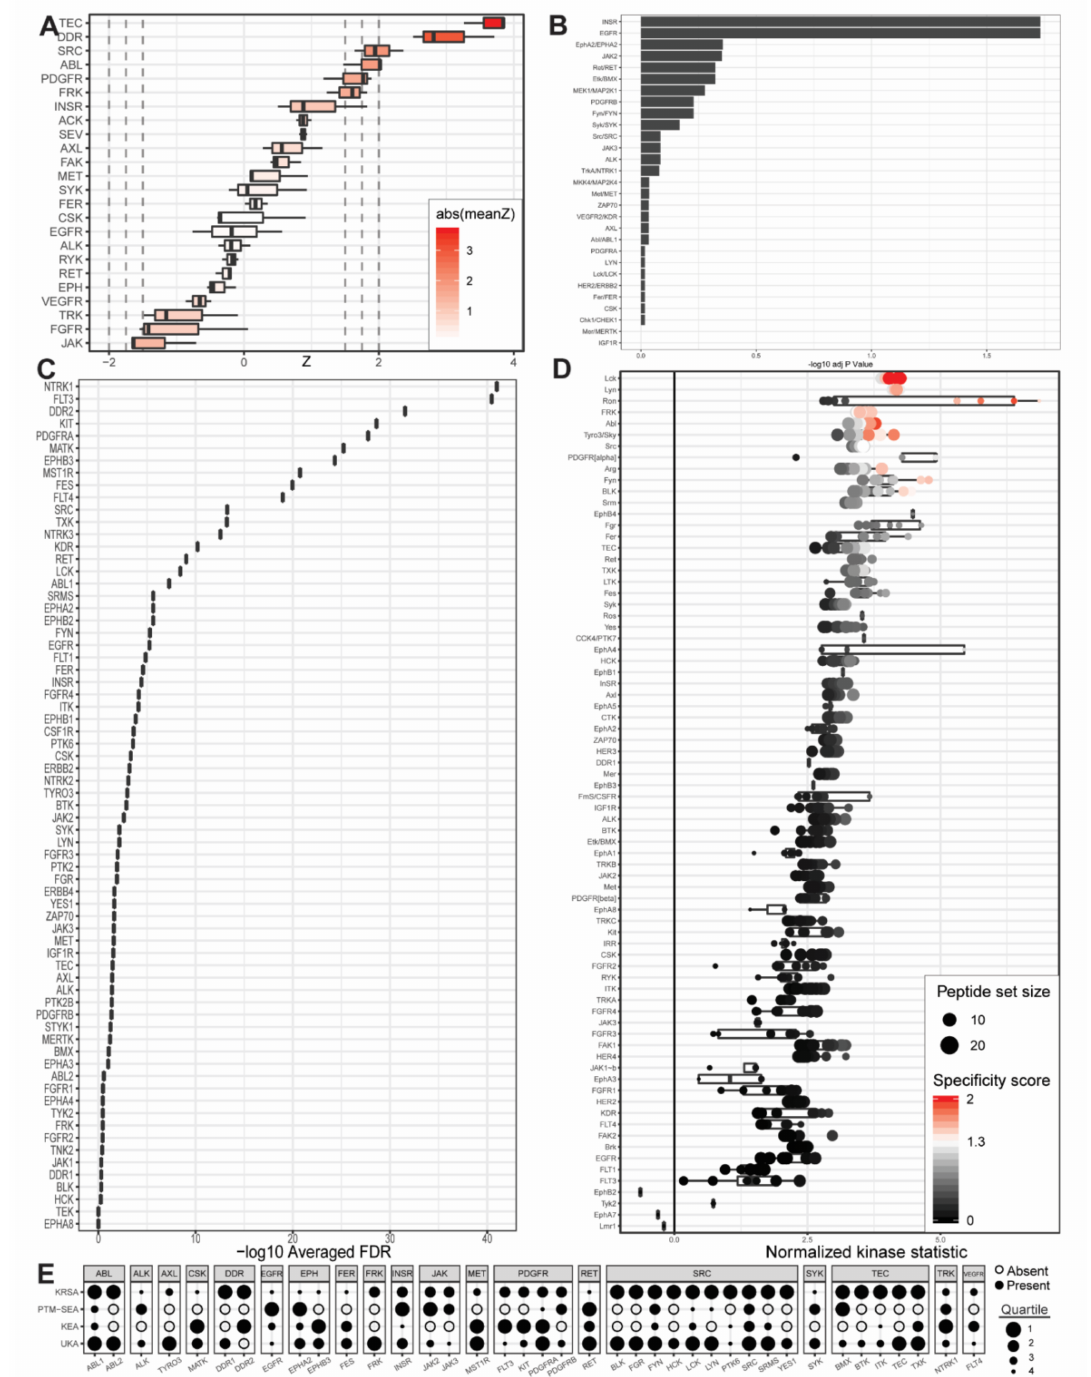
Figure 2. Outputs from upstream kinase identification pipelines for the commercially available PANC1 PDAC cell line compared to patient-derived wild-type pancreatic tissue. ( A ) Kinome Random Sampling Analyzer (KRSA); ( B ) Post-Translational Modification Signature Enrichment Analysis (PTM-SEA); ( C ) Kinase Enrichment Analysis Version 3 (KEA3); ( D ) Upstream Kinase Analysis (UKA); ( E ) Quartile summary. A more detailed figure legend can be found in Appendix